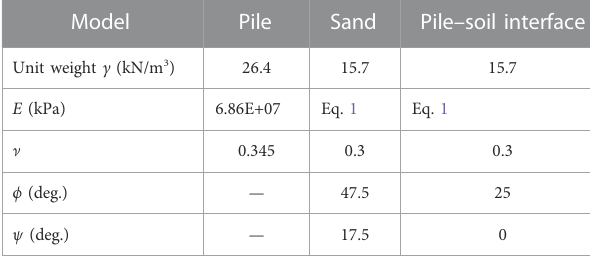
TABLE 1 Input parameters for the pile – soil